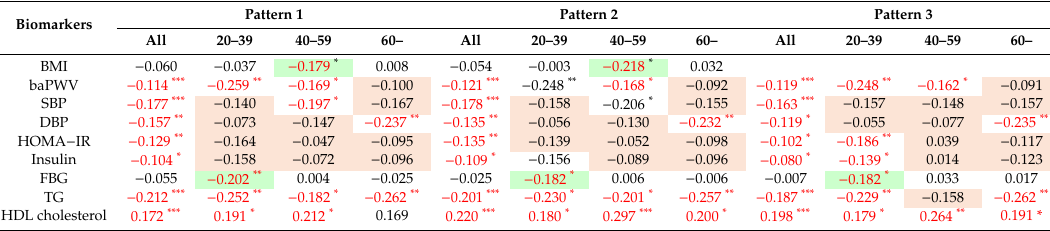
Yellow background color: relationship become non-significant by stratifying by age categories. Green background color: relationship become significant by stratifying by age categories. * p < 0.05, ** p < 0.01, *** p < 0.001. Significant values are shown in red. Pattern 1: calculated using multiple linear regression analysis after adjusting for age, antihypertensive drug use, and vitamins A, C, and E in the blood. Pattern 2: calculated using multiple linear regression analysis after adjusting for age, antihypertensive drug use, smoking habits, exercise habits, alcohol intake, and vitamins A, C, and E in the blood. Pattern 3: calculated using multiple linear regression analysis after adjusting